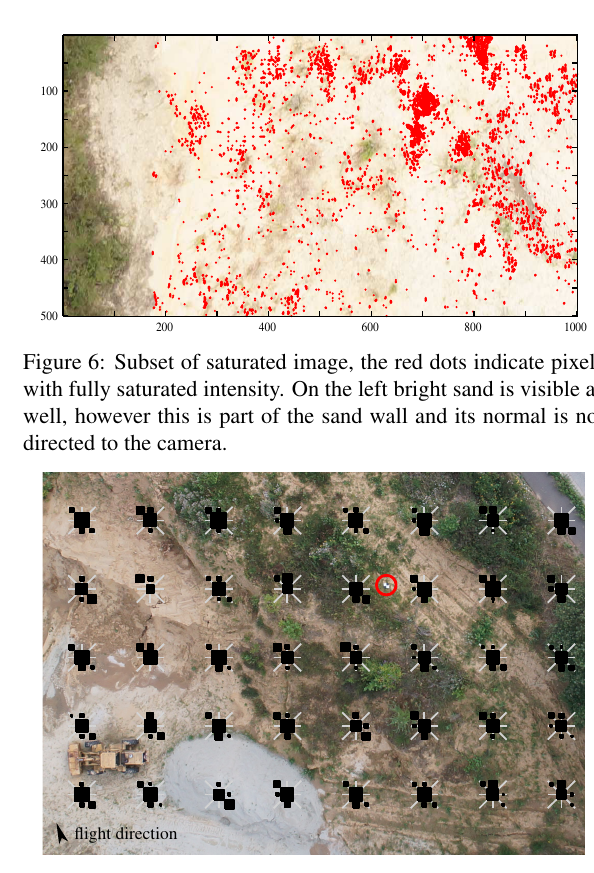
Figure 7: A subset of the center from a fixed-wing acquisition, imposed its estimated blur kernels. Furthermore, on the top mid- dle a control point (checkerboard) is indicated by a red